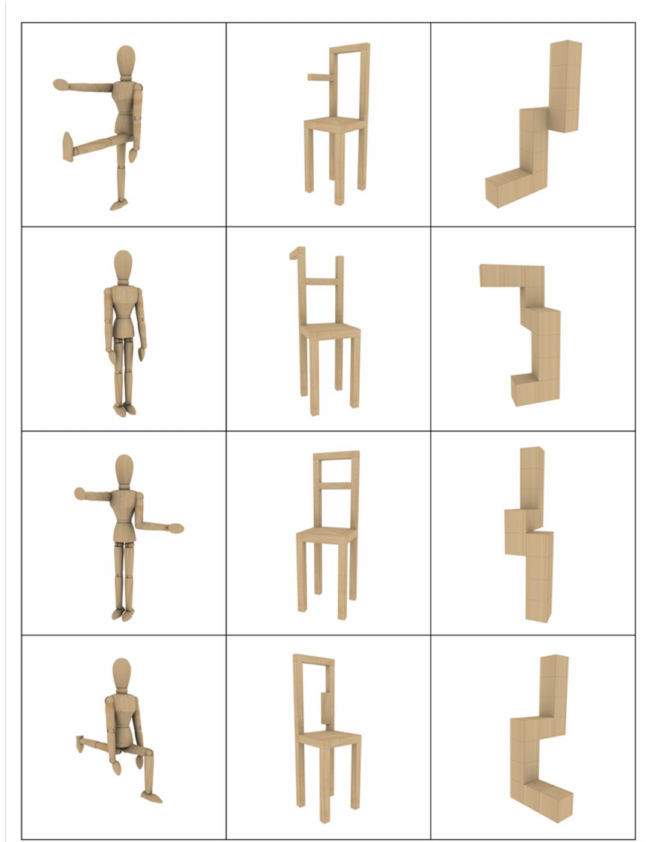
Figure 1. Example of stimuli. The figure shows a few examples of the stimuli used in the present study. Bodies (wooden dummies), objects (chairs), and cube structures were created as 3D graphics. The stimuli set included 240 di ff erent images: 16 models for each of the three categories of stimuli, presented from five di ff erent points of view obtained by rotating each model along its vertical axis ( − 40 ◦ , − 20 ◦ , 0 ◦ , + 20 ◦ , + 40 ◦